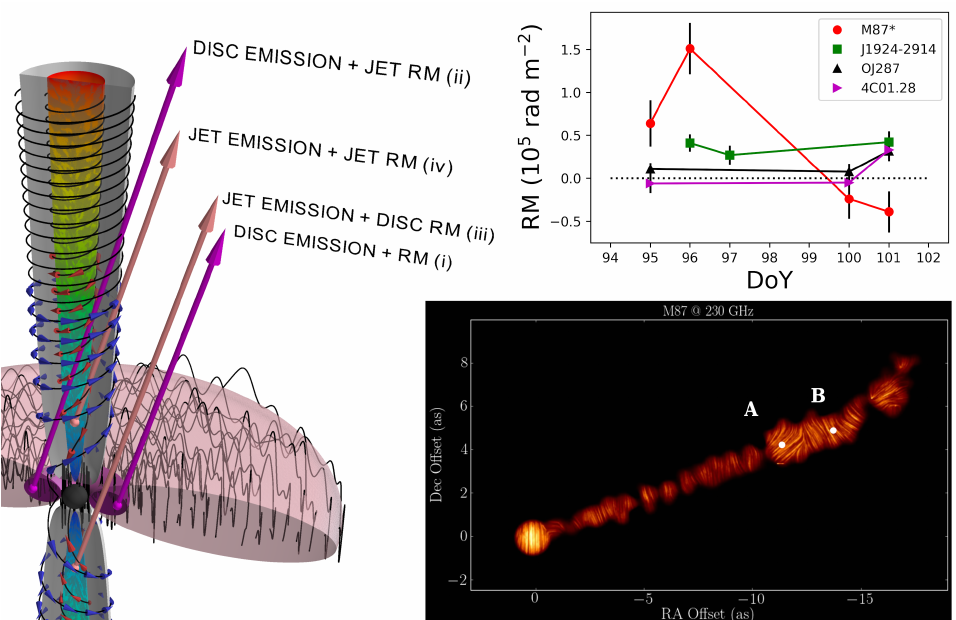
Figure 1. ( Left ) sketch of the core region of an AGN. Black lines represent the magnetic field (the blue arrow heads indicate the (cid:126) B direction in the outer jet; the red arrow heads indicate the (cid:126) B direction in the inner jet). The jet spine is colored representing synchrotron self-absorption (i.e., colors corresponding to higher frequencies come from regions closer to the SMBH) and is surrounded by a jet sheath (in gray). The accretion flow is shown in light (outer part) and dark (inner part) magenta. The thick arrows indicate the possible paths followed by non-thermal emission on its way towards Earth. Figure not to scale. ( Top right ) time evolution of the RM measured for several AGN observed with ALMA in 5–11 April 2017 [15]. ( Bottom right ) ALMA image of M87 at 230GHz in full polarization [15], plotted using the algorithm used in [12] (see their Figure 7). The location of the A and B jet knots is marked with white